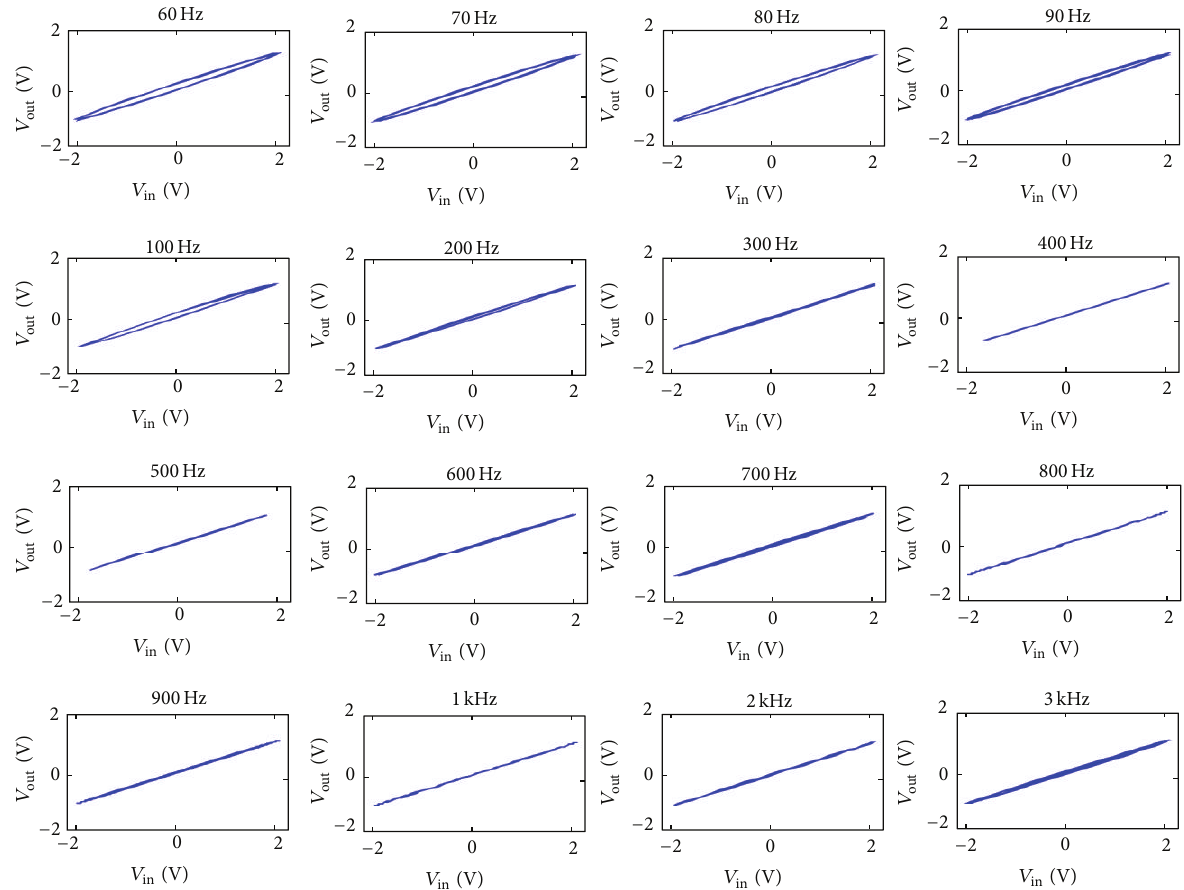
Figure 7: Lissajous curves on measured input ( V in ) and output ( V out ) voltages in the frequency range between 60Hz and 3kHz for the device IPMC AbsT- 5 h